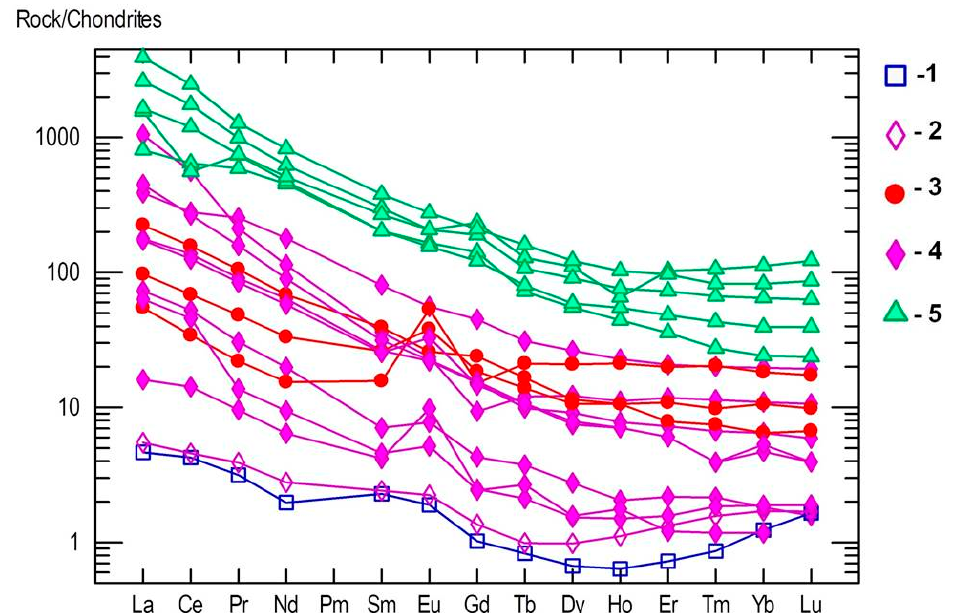
Figure 13. Chondrite-normalized REE spider diagram for the reaction rim between kyshymites and meta-ultramafic host rock (blue squares—1), meta-ultramafic host rocks (purple diamonds—2), kyshtymites (red circles—3), miascites (purple diamonds—4), and carbonatites (green triangles—5) of the Ilmenogorsky-Vishnevogorsky complex modified after [18] and Medvedeva E.V. (unpublished data); REE values in chondrite are after [41].